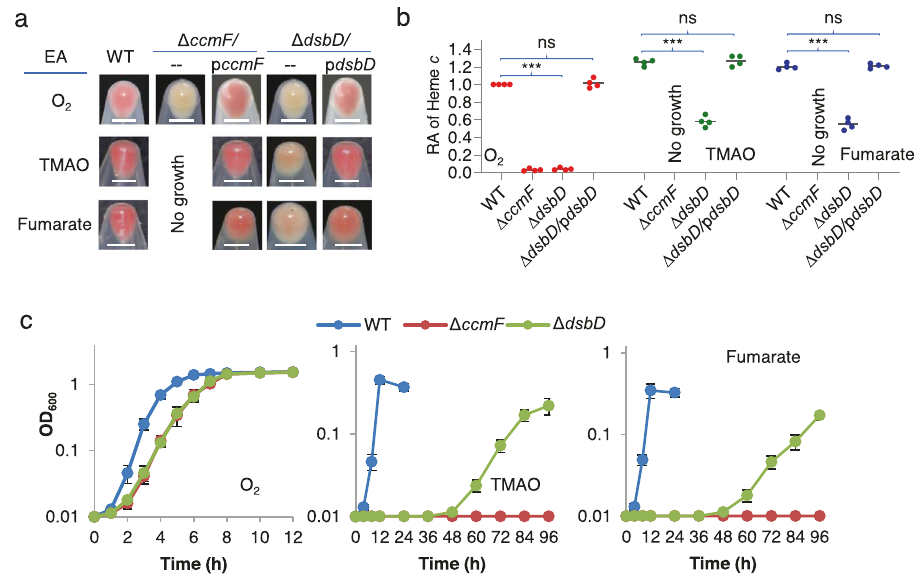
Fig. 2 S. oneidensis dsbD mutants can grow both aerobically and anaerobically. a The cell color phenotypes of indicated strains. Shown were cell-pellets of indicated strains grown on one of EAs, O 2 , TMAO, and fumarate, to the early stationary phase. Strains include WT (the wild-type), Δ dsbD and Δ ccmF carrying the empty vector (--) and respective complementary vectors (p dsdD and p ccmF ). Throughout this study, all strains without expressing a plasmid- borne gene carried empty vectors unless otherwise noted. Scale bars shown in all subpanels, 5 mm. b Heme c levels. Samples used in ( a ) were lysed for quanti fi cation of heme c . After quanti fi cation (Supplementary Fig. 2a), the data were fi rst adjusted according to protein levels of samples, and then the averaged levels of the mutants were normalized to that in the wild-type, which was set to 1, giving to relative abundance (RA). Asterisks indicate statistically signi fi cant difference of the values compared ( n = 4; ns, not signi fi cant, p > 0.05; * P < 0.05; ** P < 0.01; *** P < 0.001). c Growth of indicated strains on EAs speci fi ed. Growth data of complementary strains were given in Supplementary Fig. 2b. All experiments were performed four times, and representative data as in ( a ), all data as in ( b ), or average ± SD (error bar) as in ( c ) were